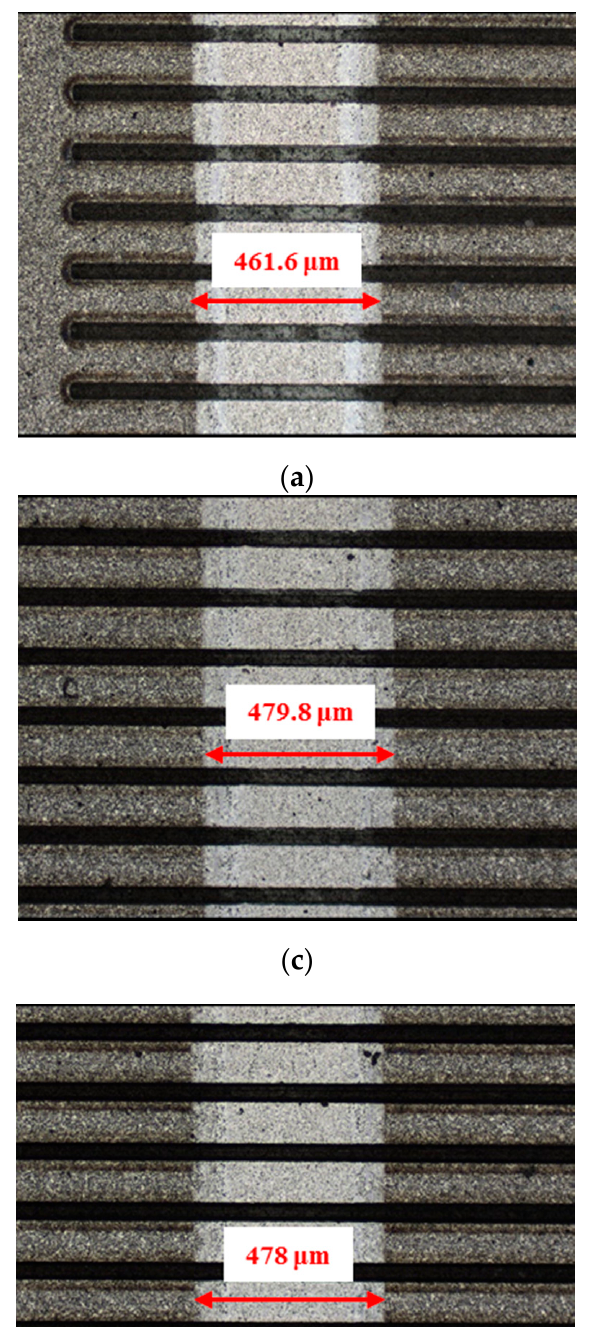
( d ) Figure 18. Cross section of wear scars under water-lubricated conditions with a load of 75 N: ( a ) circular-dimple-textured SiC–steel ball, ( b ) groove-textured SiC–steel ball, ( c ) circular-dimple-textured SiC–Si 3 N 4 ball, and ( d ) groove-textured SiC– Si 3 N 4 ball. 5. Conclusions The frictional and wear performance of a textured surface against several types of materials under dry, oil-lubricated, and water-lubricated conditions were experimentally studied in this paper. The friction coefficient and wear scar width and depth of un-tex- tured, circular-dimple-textured, and groove-textured surfaces were examined and com- pared. Considering the experimental results, the following conclusions can be drawn: 1. Texture depth and texture shape affected the friction and wear performance of tex- tured surfaces. However, the influence varied under dry, oil-lubricated, and water-